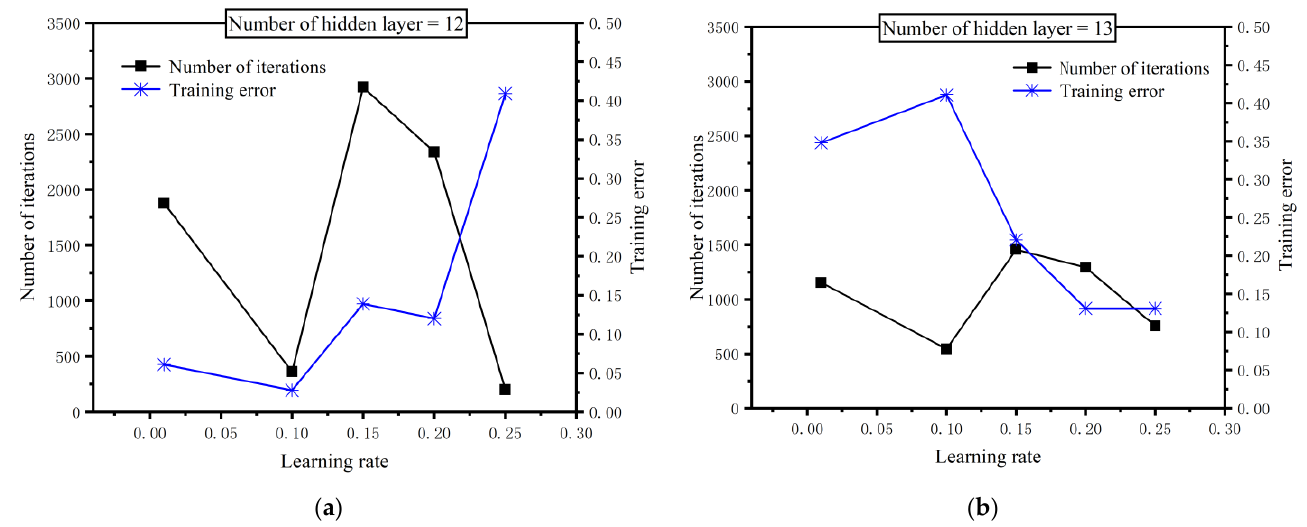
Figure 5. Performance comparison with different hidden layers: ( a ) indicates the situation where the learning rate is 0.01; ( b ) indicates the situation where the learning rate is 0.10; ( c ) indicates the situation where the learning rate is 0.15; ( d ) indicates the situation where the learning rate is 0.20.